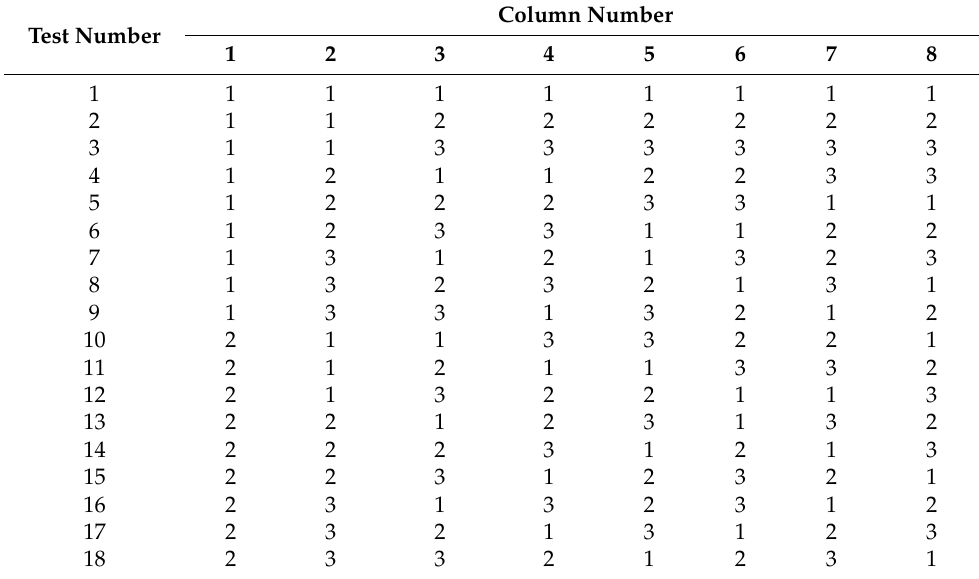
Table 1. L 18 (2 × 3 7 ) orthogonal